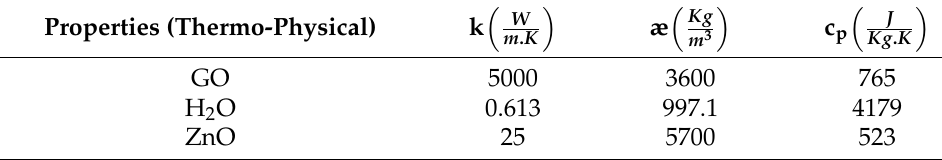
Table 1. Thermo-physical properties of GO, ZnO, and H 2 O [40].